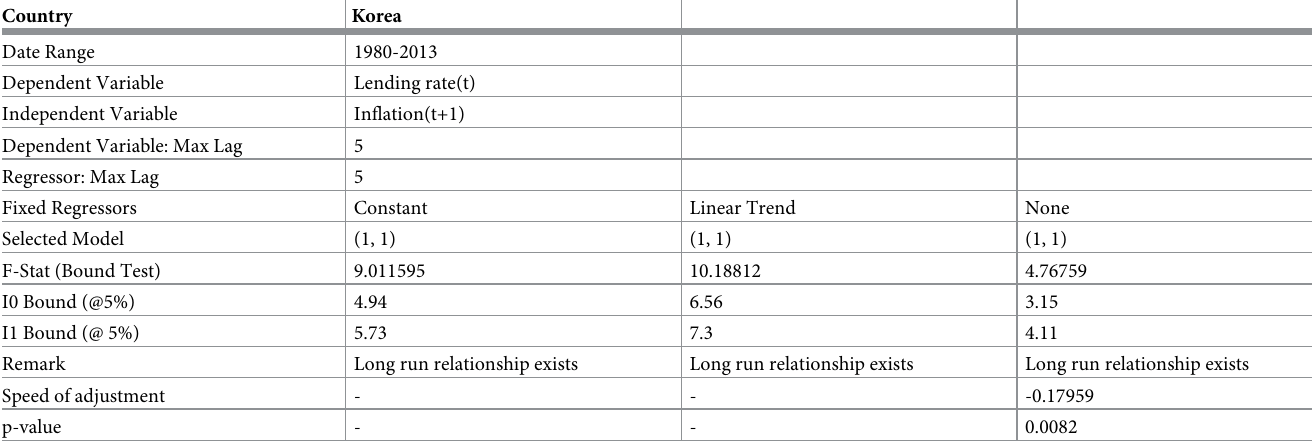
Table 27. ARDL Bounds Testing for Korean data under Fisherian framework.